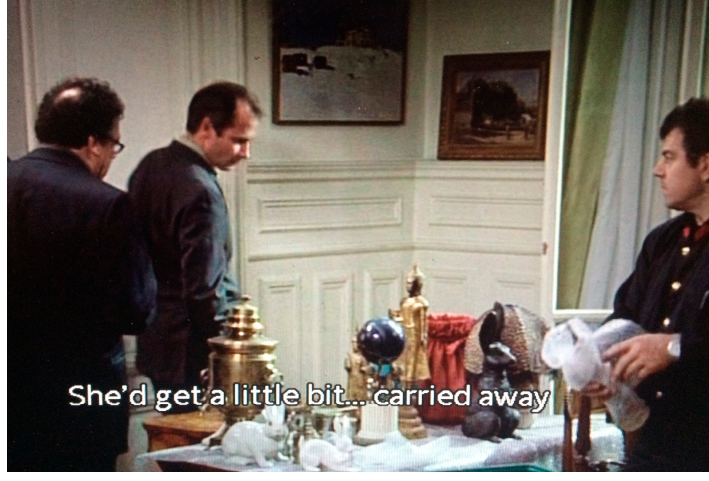
Figure 7. Preparation for Auction.